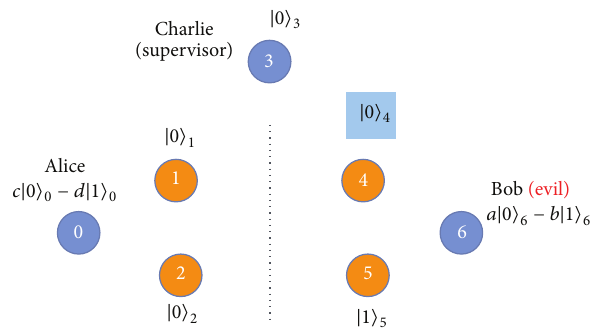
Figure 16: Bob publishes an incorrect measurement result of qubit